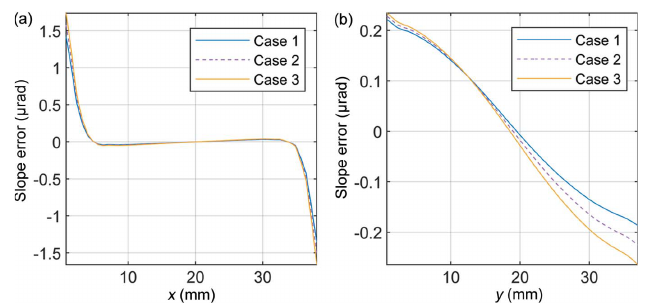
Figure 5 Slope errors across the centre line of the optical surface of the crystal in the ( a ) sagittal and ( b ) meridional directions.